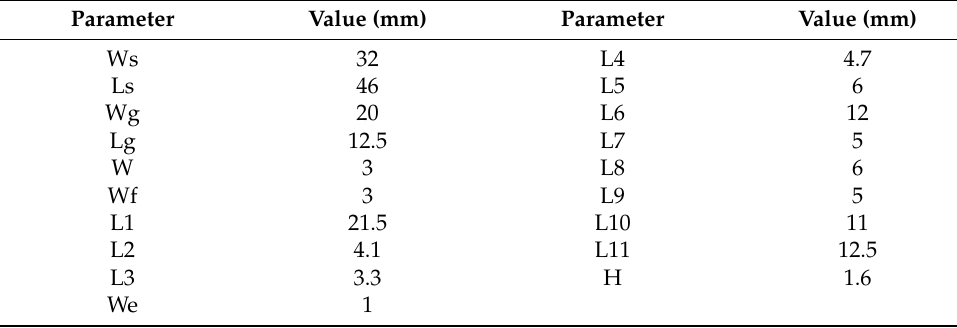
Figure 1. Geometric views of Hybrid antenna. Table 1. Design Parameters of Hybrid Antenna.